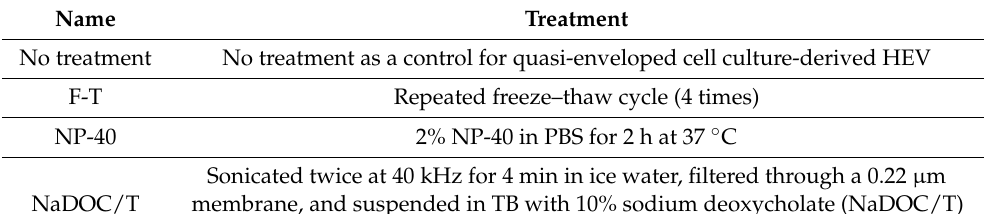
Table 2. Treatments of cell culture supernatant for iodixanol gradient